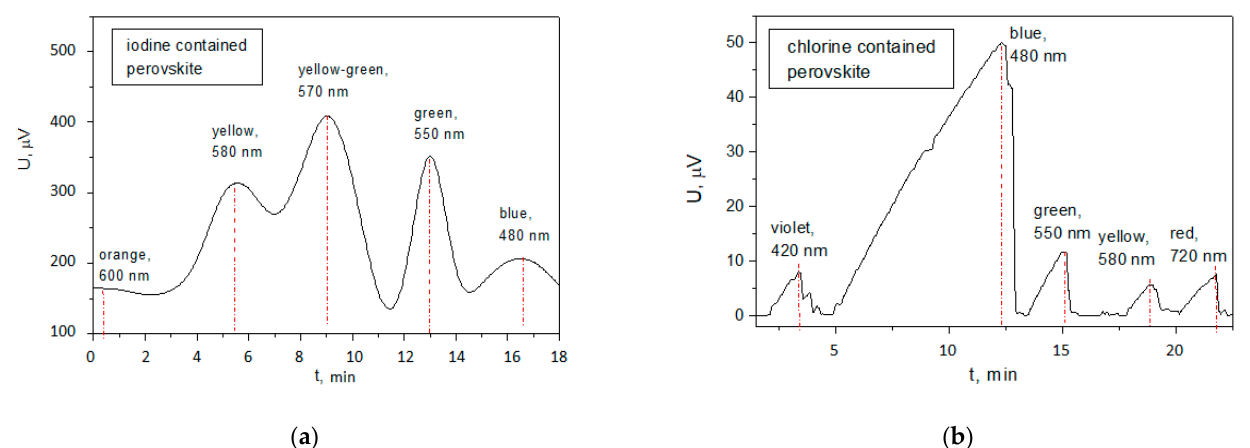
Figure 7. Spectral sensitivity of the solar cell with: ( a ) iodine-based perovskite film; ( b ) chlorine-based perovskite film.